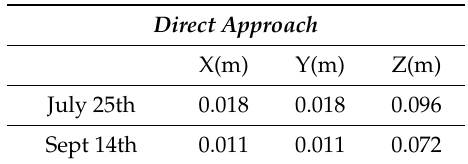
Table 8. Mean standard deviation of five check points from direct approach for the DJI M200 thermal platform from mini bundle adjustment.